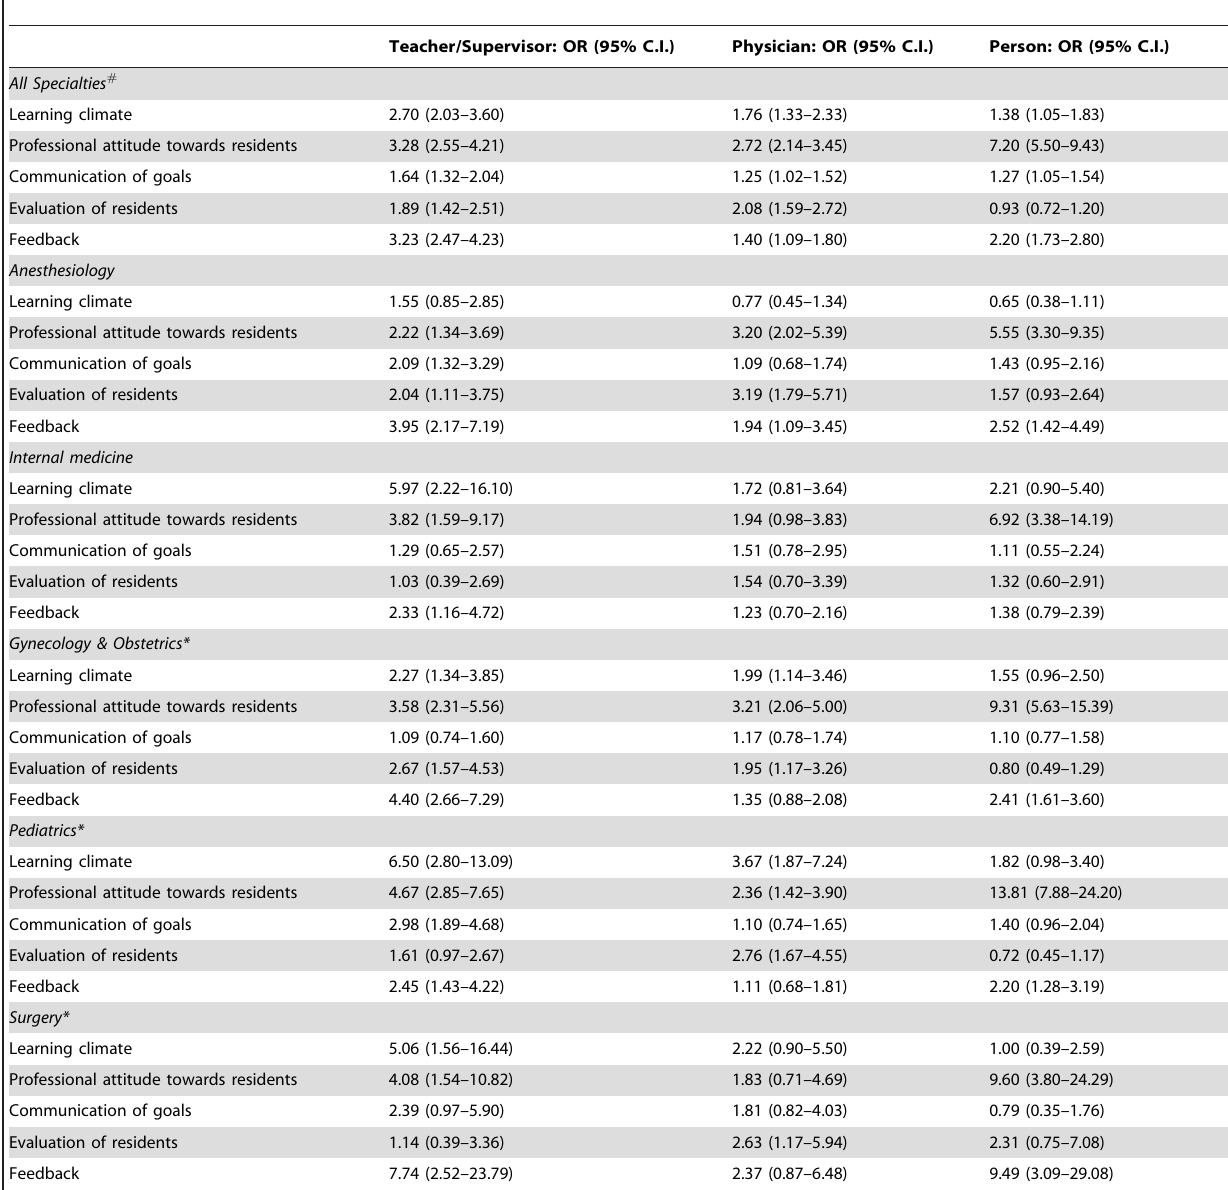
Table 4. Odds ratios (OR) for the adjusted associations between faculty’s specific domains of teaching performance and the different types of role models as seen by the residents.